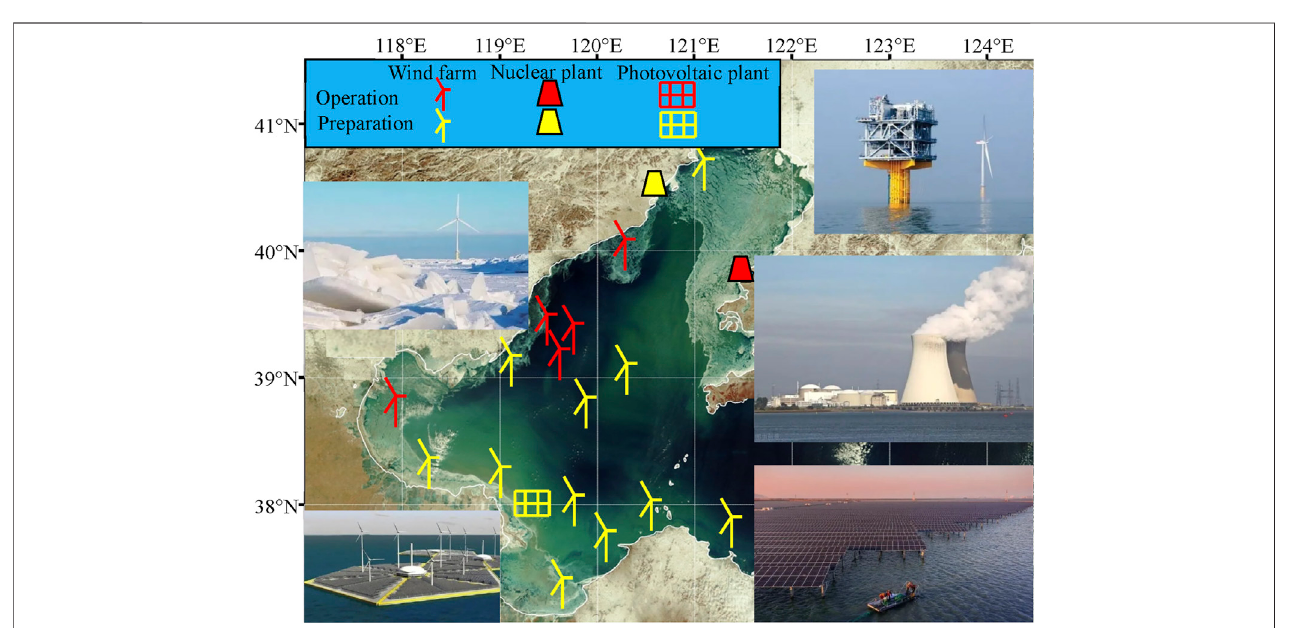
FIGURE 3 | Overview of new-energy power generation development in the Bohai Sea.